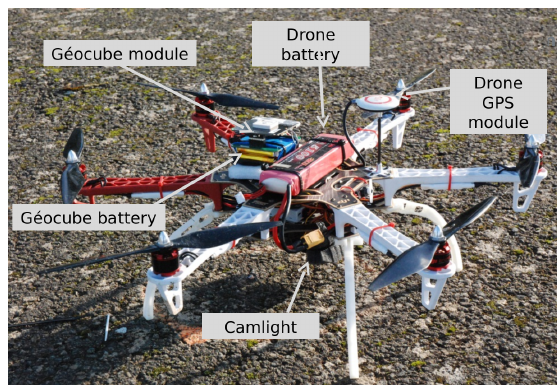
Figure 1: The drone DJI-F550 with GPS and onboard camera